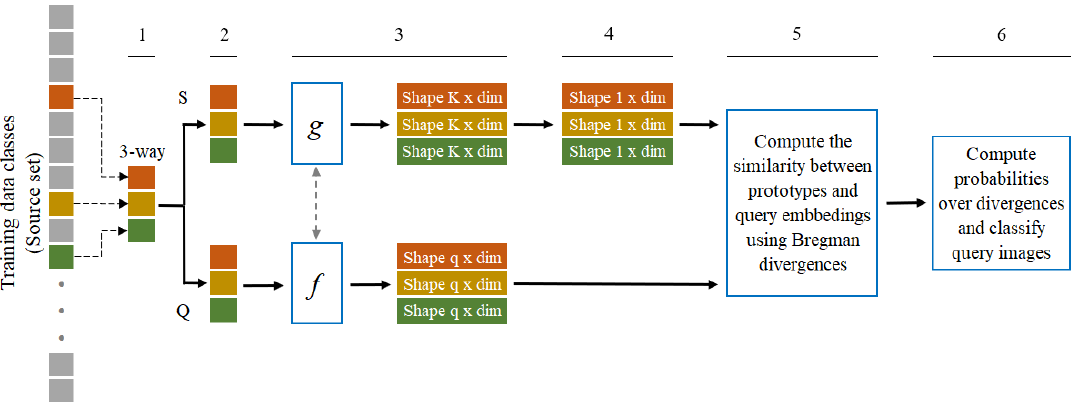
Figure 4. A generalized episode of prototypical networks, where ’dim’ represents the dimension of the vectors. (1) Random selection of classes. (2) Samples division into support and query sets. (3) Embeddings generation. (4) Prototypes